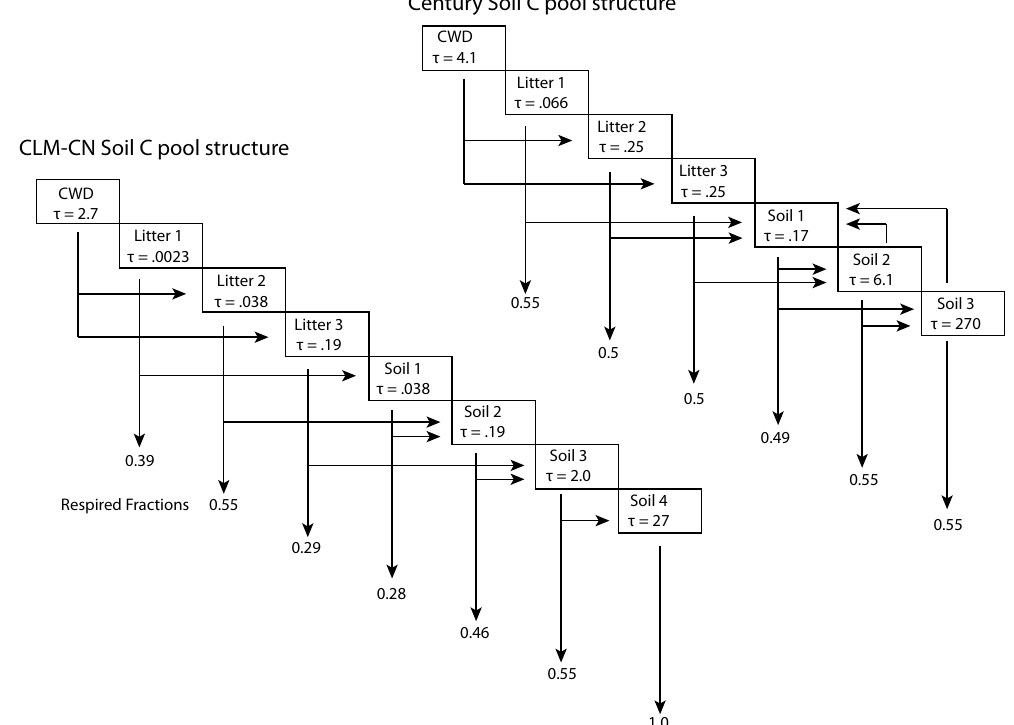
Fig. 2. Comparison of 2 decomposing pool cascade structures and parameters used in this study. Turnover times (in boxes) are in years. Numbers at end of arrows are respired fractions. Summarized information in Tables 1 and